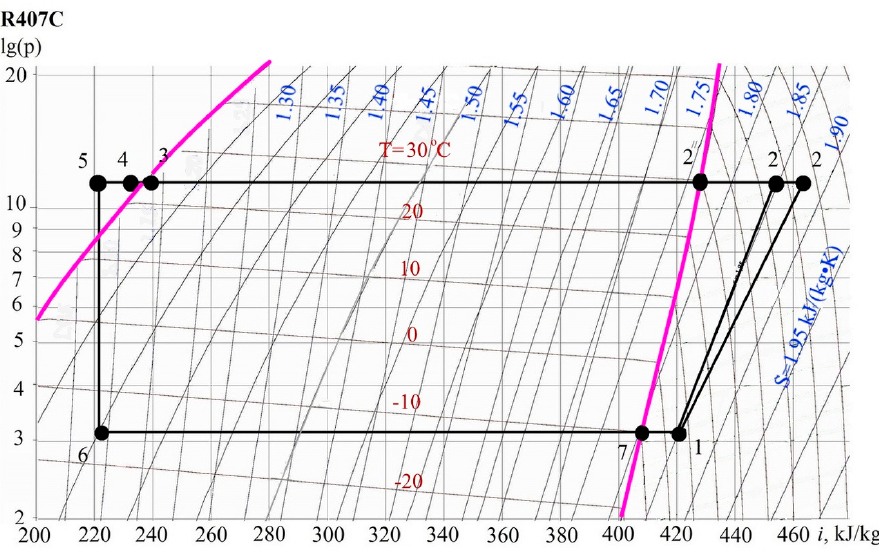
Figure 5. The diagram lg(p)-i.